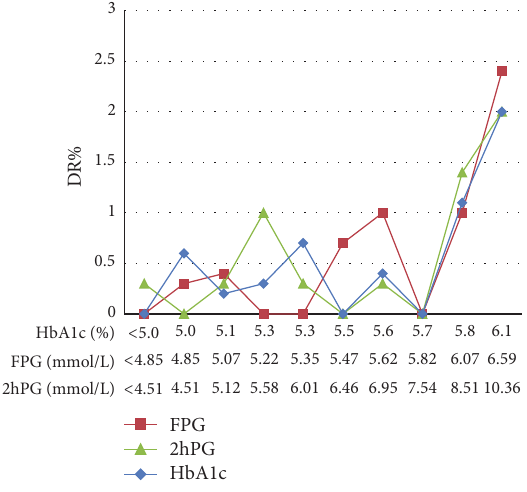
Figure 4: Prevalence of diabetic retinopathy (DR) according to the deciles of distribution of fasting plasma glucose (FPG), 2-hour postload plasma glucose (2hPG), and glycated hemoglobin A1c (HbA1c) in 2959 subjects after excluding those with known diabetes. The 𝑥 -axis indicates the minimum value of each decile group.